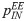
Basic properties of excitatory and inhibitory neurons in balanced networks.(A) Clustered network connectivity (left) of inhibitory-inhibitory (pII), excitatory-to-inhibitory (pIE), inhibitory-to-excitatory (pEI), same-cluster excitatory-excitatory (pINEE), and out-of-cluster excitatory-excitatory (pOUTEE) neuron pairs. Average firing rates (right) of excitatory (red, 3.2 ± 2.9 Hz, mean ± standard deviation) and inhibitory (blue, 4.1 ± 2.7 Hz) neurons. (B) Non-clustered network connectivity (left) and average firing rates (right) of excitatory (red, 2.0 ± 1.7 Hz) and inhibitory (blue, 2.9 ± 1.9 Hz) neurons. (C) Clustered network spike count correlations (one second time bins) between same-cluster excitatory-excitatory pairs (EEin, red, r = 0.72 ± 0.27, mean ± standard deviation), out-of-cluster excitatory-excitatory pairs (EEout, green, r = -0.0085 ± 0.11), excitatory-inhibitory pairs (EI, purple, r = 9.0−4 ± 0.14), and inhibitory-inhibitory pairs (II, blue, r = 4.5−4 ± 0.15). (D) Non-clustered network spike count correlations (one second spike bins) between excitatory-excitatory pairs (EE, red, r = 1.9−5 ± 0.11), excitatory-inhibitory pairs (EI, purple, r = 2.1−4 ± 0.018), and inhibitory-inhibitory pairs (II, blue, r = -7.3−4 ± 0.025). Note that the horizontal axis differs between panels C and D. (E) Clustered network spiking activity. A representative sample of 500 neurons (100 inhibitory neurons and 400 excitatory neurons ordered by cluster membership. (F) Non-clustered network spiking activity. A representative sample of 500 neurons (100 inhibitory and 400 excitatory).